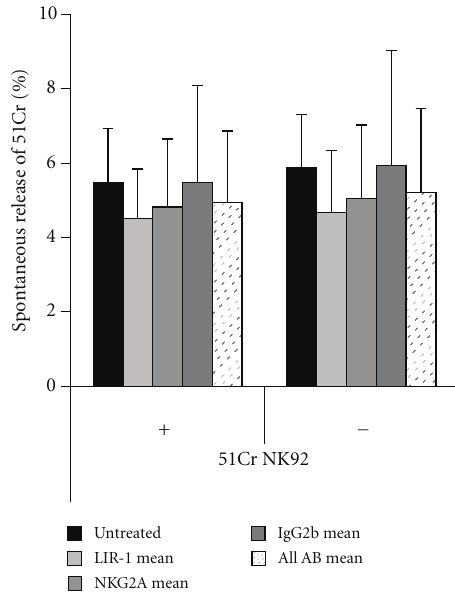
Figure 8: Neither antibodies nor F(ab (cid:3) ) 2 show toxic e ff ects on NK-92 cells. NK-92 were labeled with 51Cr and incubated with Abs against LIR-1, NKG2A, or IgG2b. Isotype control with (+) or without ( − ) F(ab (cid:3) ) 2 is under the same conditions as the unlabeled e ff ector cells in the blocking experiments. SR is given as mean of four independent experiments for untreated NK cells and as mean of an experimental series with concentration of 10, 1 and 0.1 μ g/mL. “All Ab mean” integrates those results. F(ab (cid:3) ) 2 concentration was 11 μ /mL. Spontaneous release was < 6%. As this control panel was performed in parallel to regular NK-92 blocking experiments, interferences by reagents, temperature, incubation period, cell viability, or technical equipment can be